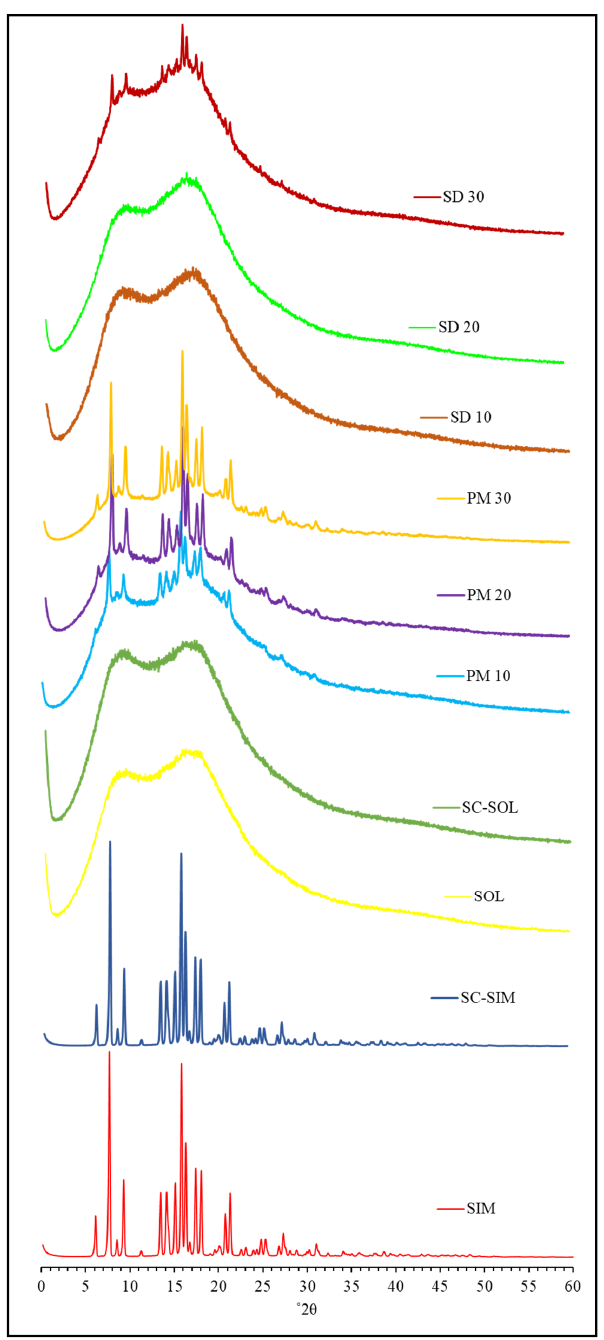
Figure 3. XRD diffractogram of Soluplus ® , Simvastatin, physical mixture (PM10, PM20, and PM30 and solid dispersions (SD10, SD20, and SD30) prepared at 50 °C and 150 bar. The XRD data obtained for SIM (raw and scCO 2 processed) confirmed its crystalline structure with typical and sharp interference peaks at 2 θ equal to 10.9°, 15°, 17.2°, 18.9°, 19.6°, and 22.1° [43]. The diffractogram of SOL displayed no peaks due to its amorphous nature. The three PMs (10, 20, and 30% w / w ) and SD30 showed similar diffraction patterns to that of SIM but with reduced intensity of the diffraction peaks. In contrast, there was